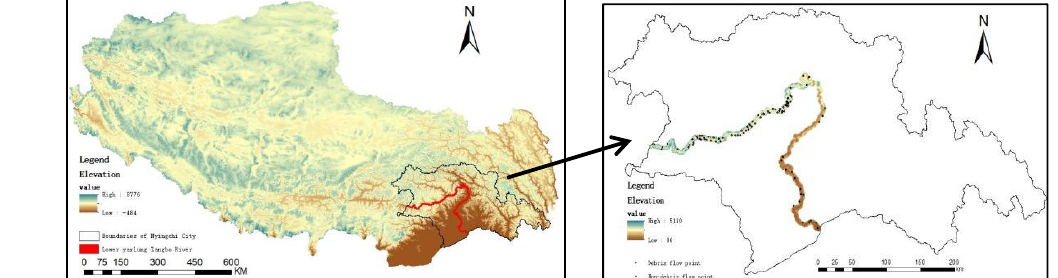
Figure 1 . Flow chart of research method.